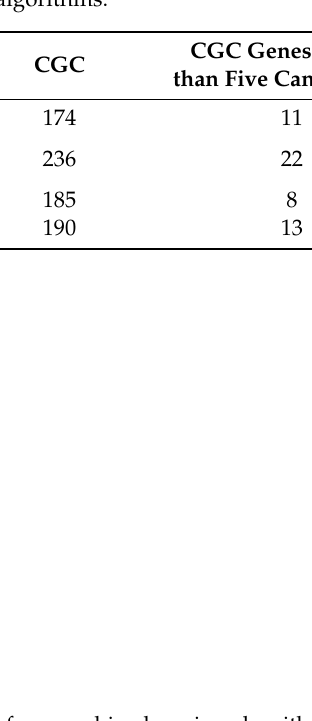
Table 2. Number of driver genes detected by the four algorithms.